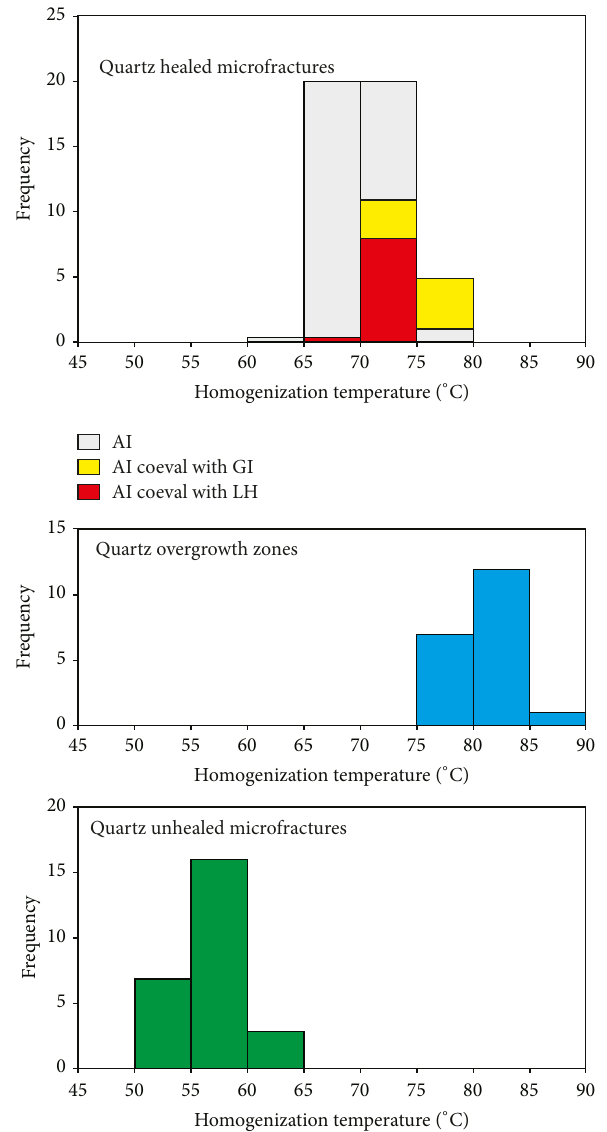
Figure 7: Histogram for homogenization temperatures of fluid inclusions in quartz healed microfractures, overgrowth zones, and unhealed microfractures.